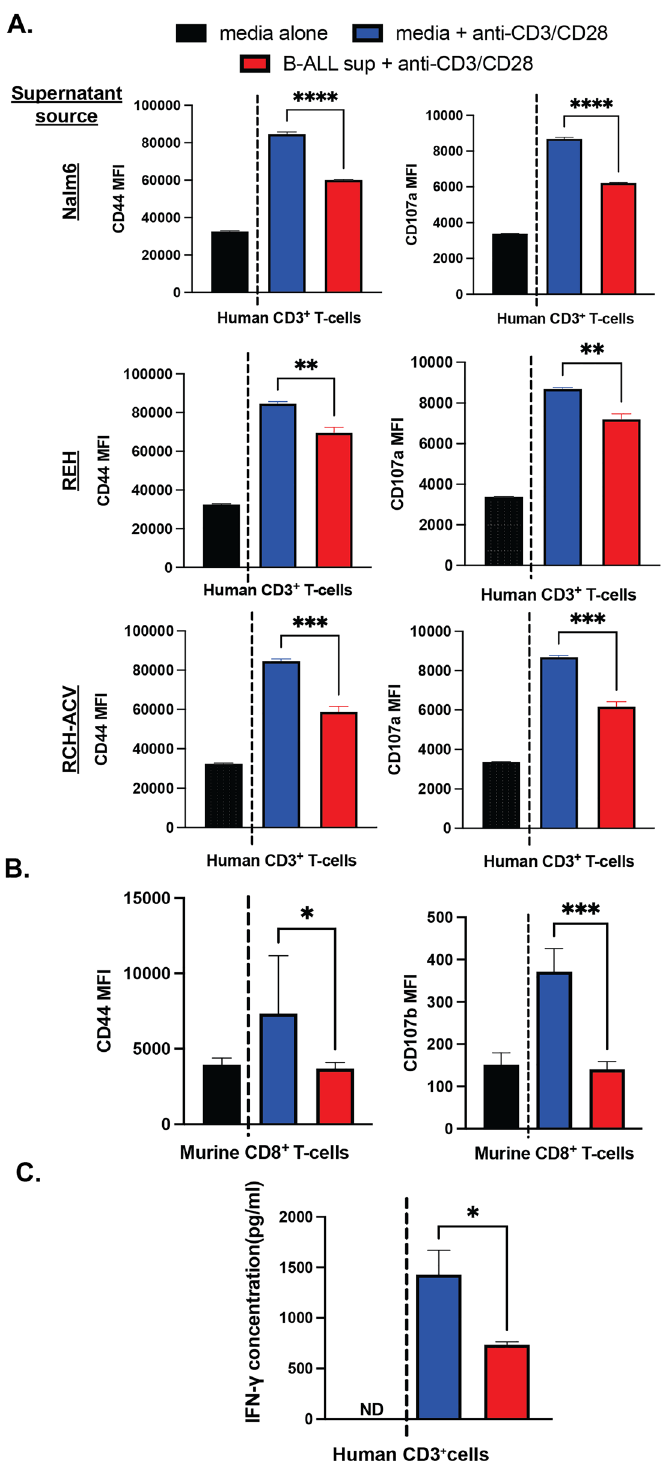
Figure 2. The B-ALL secretome suppresses T-cell activation . ( A ) CD3 + human T-cells stimulated ex vivo with CD3/CD28 antibodies were co-cultured in either Nalm6, REH or Rch-Acv supernatant for 48 h and analyzed via flow cytometry. Graphs depict mean fluorescence intensity (MFI) for CD44 (left) and CD107a (right) antibodies ( n = 2 independent experiments; * P < 0.05; ** P < 0.01; **** P < 0.0001, ANOVA with Tukey multiple comparisons test) ( B ) Murine splenocytes were stimulated ex vivo with CD3/CD28 antibodies and cultured with B-ALL supernatant (Nalm6) and analyzed by flow cytometry ( n = 3 independent experiments; * P < 0.05; ** P < 0.01; **** P < 0.0001, ANOVA with Tukey multiple comparisons test). ( C ) ELISA for IFN-γ from supernatant of human T-cells cultured in B-ALL conditioned